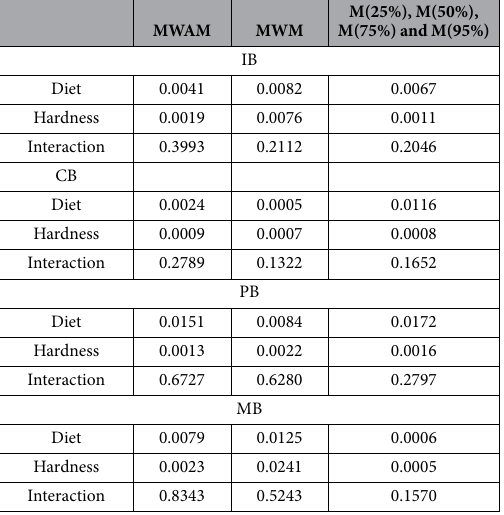
Table 3. p-values for the Two-Way PERMANOVA for the four biting cases (IB: Incisive Bite, CB: Canine Bite, PB: Premolar Bite and MB: Molar Bite) when analysing MWAM, MWAM and all the percentiles